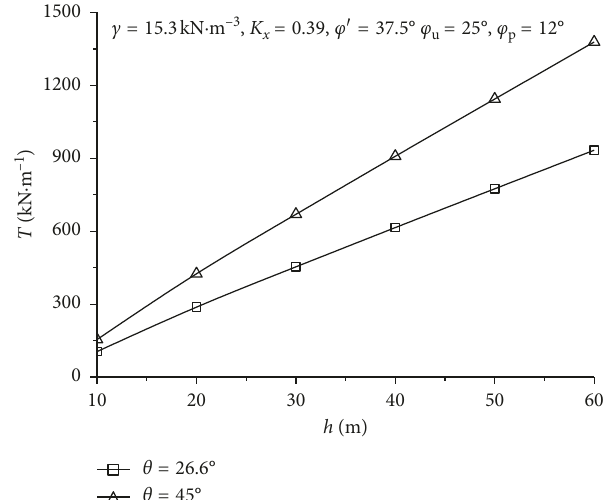
Figure 7: Relationship between the maximum tensile force at the anchored end and the buried